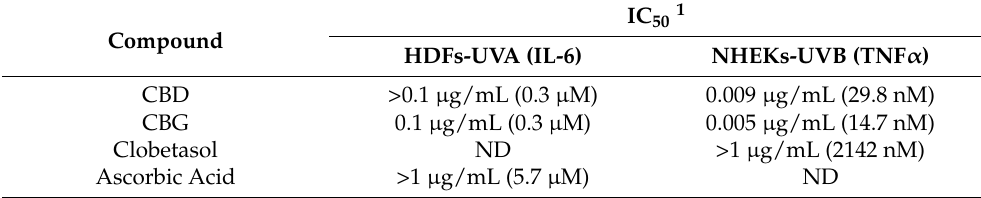
Table 2. Summary of in vitro photoaging activity.